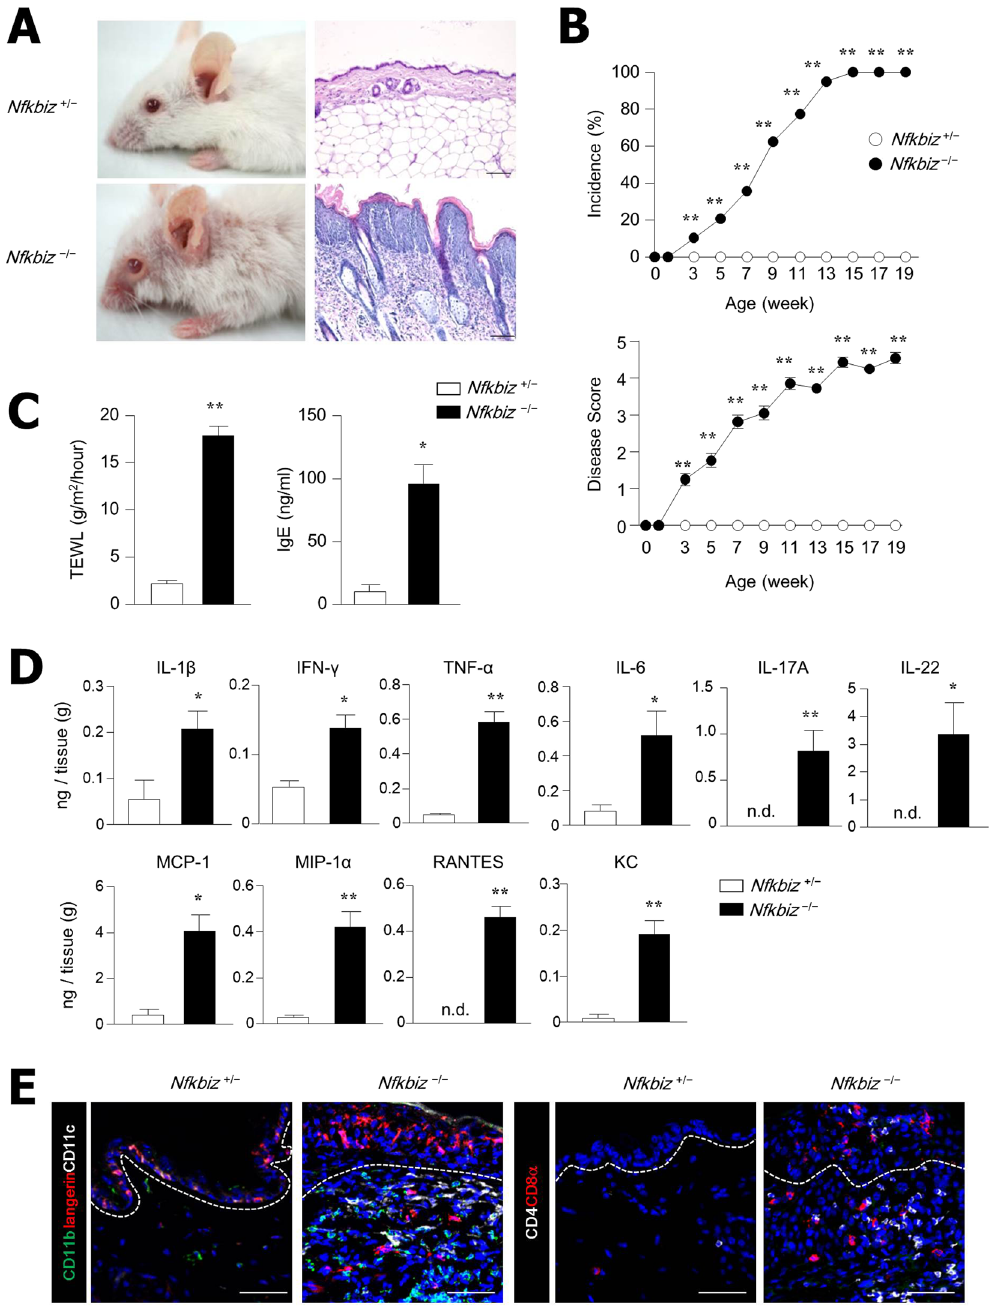
Figure 1. Spontaneous skin inflammation develops in Nfkbiz − / − mice. ( A ) Representative skin phenotype and histology of skin biopsy from Nfkbz + / − and Nfkbiz − / − mice at age 10 weeks. Scale bar = 50 µ m. ( B ) Disease incidence and progression of dermatitis in Nfkbiz + / − and Nfkbiz − / − mice (n = 20). Dermatitis incidence (score ≥ 3) is shown as a percentage. ( C ) Trans-epidermal water loss (TEWL) and serum IgE antibody levels in Nfkbiz + / − and Nfkbiz − / − mice. ( D ) Cytokines and chemokine levels in a skin homogenate. ( E ) Confocal microscopy of skin biopsies from Nfkbiz + / − and Nfkbiz − / − mice. Scale bar = 50 μ m. Data are representative of three independent experiments. All data are mean ± s.e.m. * p < 0.05, ** p <